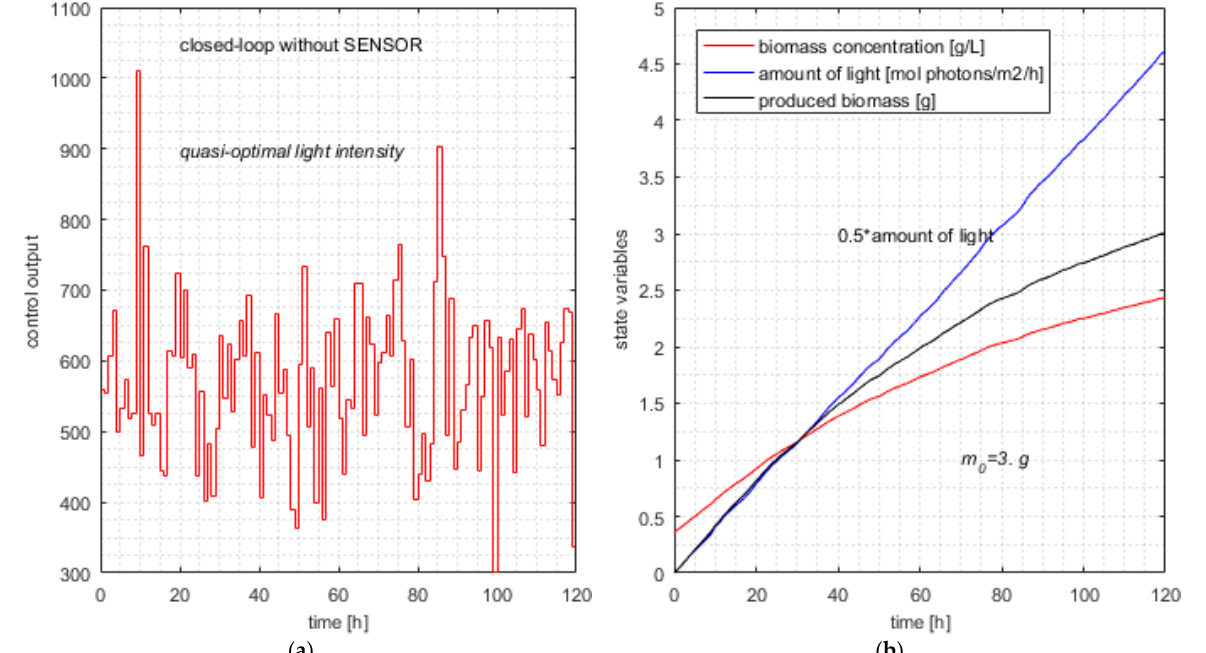
Figure 6. Typical simulation of the closed loop without soft sensor. ( a ) Typical control output without SENSOR; ( b ) quasi- optimal evolution of state variables and produced biomass in the typical execution.